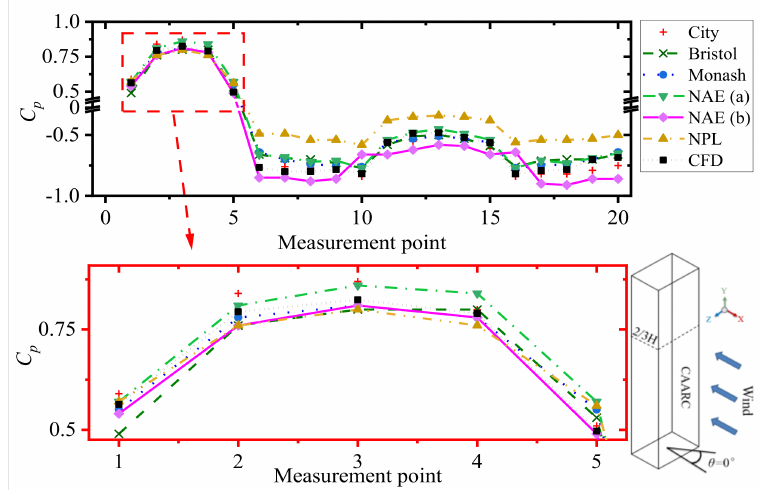
Figure 3. The comparison of the wind pressure at the surface measurement points of the CAARC model with wind tunnel test